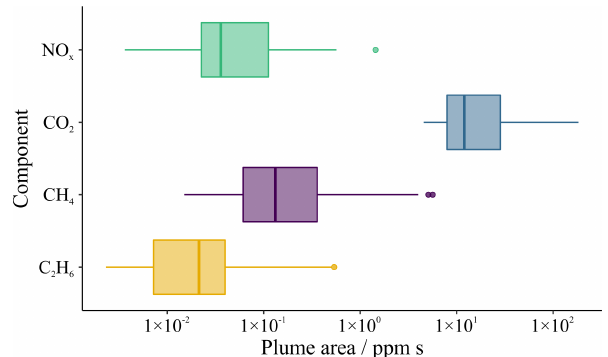
Figure 3. Box and whisker distributions of integrated plume areas (in ppms) above background for NO x , CO 2 , CH 4 , and C 2 H 6 across the 58 identified flaring plumes. Box edges correspond to the first and third quartile (i.e. the 25th and 75th percentile) with the thicker, central line denoting the sample median (i.e. 50th percentile). The upper whisker extends to the greatest value no more than 1.5 multi- ples of the interquartile range (IQR) from the 75th percentile value. The lower whisker extends to the smallest value no less than 1.5 multiples of the IQR from the 25th percentile. Data beyond the ex- tents of the whiskers were considered outlying points and were plot- ted individually (as circles). Note that the x axis has a logarithmic scale.